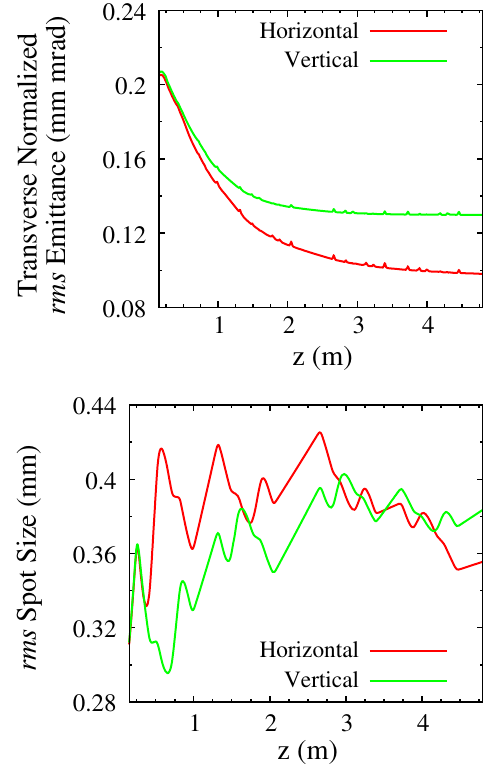
FIG. 8. Transverse normalized rms emittances (top) and spot sizes (bottom) of bunch passing through the linac.